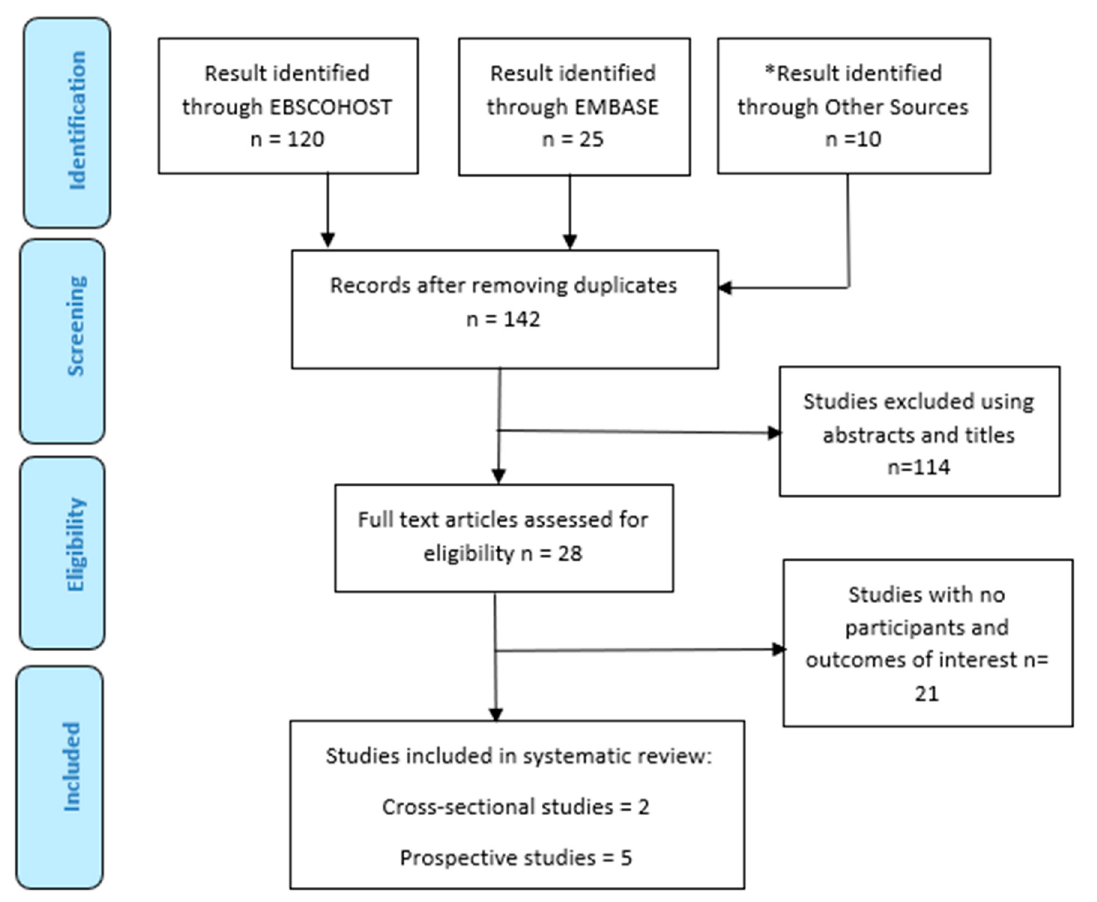
Figure 1. The PRISMA flow chart of included studies. * Other Sources refer to Google Scholar and the reference list of articles.